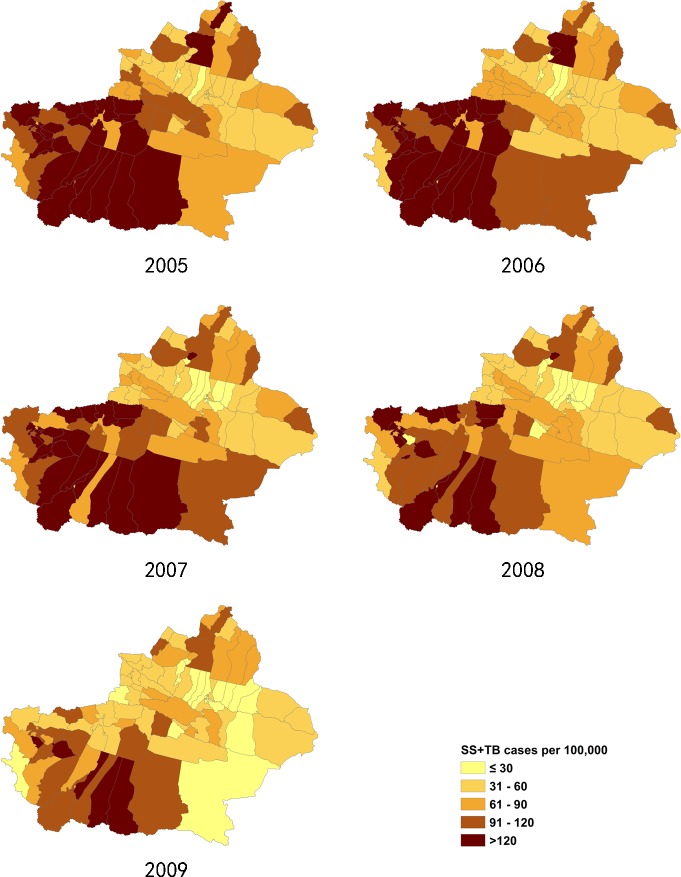
The incidence of SS+TB cases in Xinjiang, from 2005–2009.